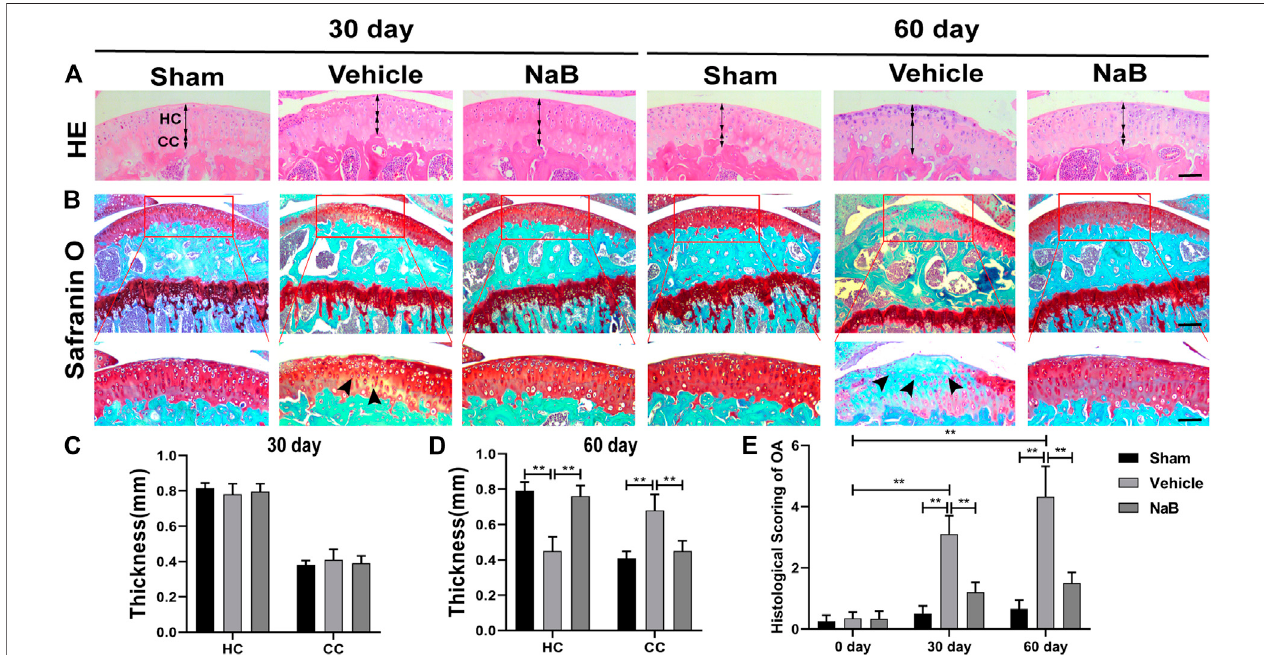
FIGURE 3 | Sodium butyrate (NaB) prevents articular cartilage degeneration after ACLT in mice. (A) Hematoxylin and eosin (HE) staining; double-headed arrows represent the thickness of hyaline cartilage (HC) relative to calci fi ed cartilage (CC). Scale bars, 100 µm. (B) Safranin O staining; solid arrows represent the loss of proteoglycans and cartilage degradation. Scale bar, 400 µm (top panels) ; 200 µm (bottom panels) . (C,D) Variations in the thicknesses of HC and CC in distinct interventiongroups and time points. (E) Histological osteoarthritis(OA) scoringfor articular cartilageat distincttime points after surgery. n (cid:2) 10per group. The data are presented as the mean ± S.D. Signi fi cant differences between different groups were determined by one-way ANOVA (C,D) or Kruskal – Wallis H test (E) ; * p < 0.05, ** p <